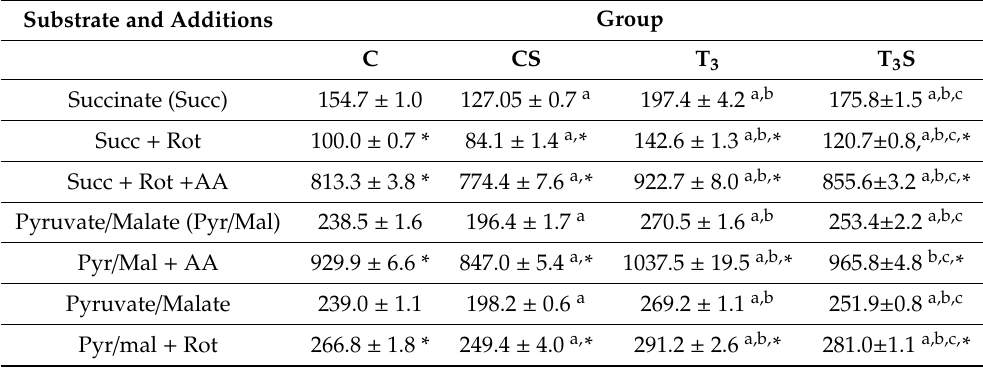
Table 2. Effect of respiratory inhibitors on H 2 O 2 release by liver mitochondria from the control, control fed Chlorella sorokiniana , hyperthyroid, and hyperthyroid fed Chlorella sorokiniana rats. Substrate and Additions